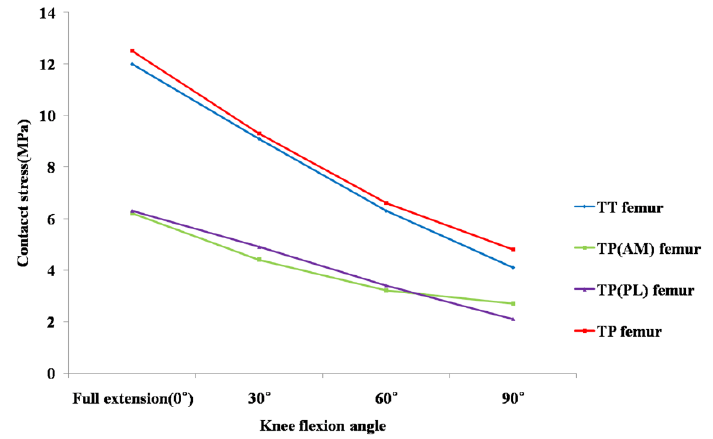
Figure 6. Comparison of contact stress at the femoral tunnel under 134 N anterior tibial load between conventional single-bundle and anatomical double-bundle anterior cruciate ligament reconstruction. Abbreviations: TT, transtibial; TP, transportal; AM, anteromedial; PL, posterolateral. The total contact stress in the tibial tunnel ranged from 3.5 MPa at 90° to 6.0 MPa at 0° flexion in SB ACL reconstruction and 3.6 MPa at 90° to 6.2 MPa at 0° flexion in DB ACL reconstruction. The total contact stress at the tibial tunnel in DB ACL reconstruction was higher than that in SB ACL reconstruction at 0°, 60°, and 90° knee flexion, even though each contact stress at the AM or PL tibial tunnel in DB ACL reconstruction was lower than in SB ACL reconstruction from 0° to 90° flexion (Figure 7).